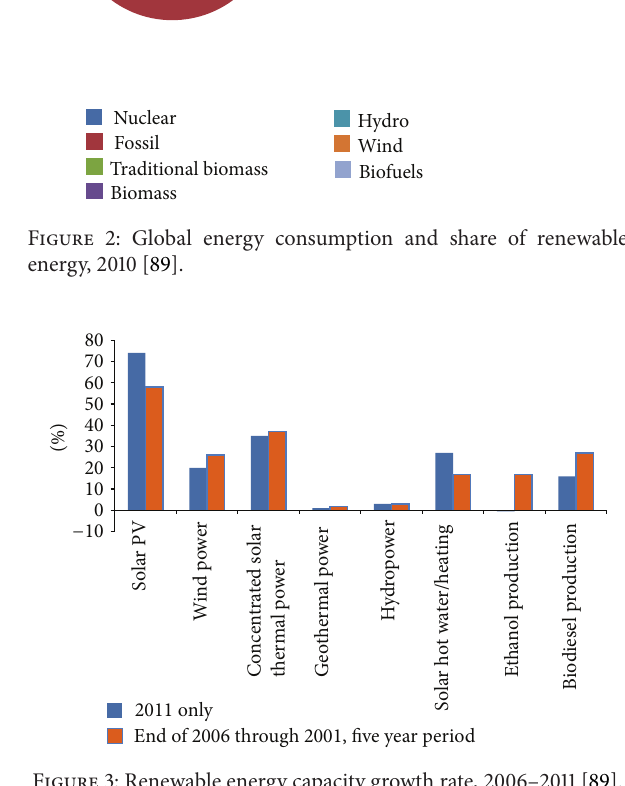
Figure 3: Renewable energy capacity growth rate, 2006–2011